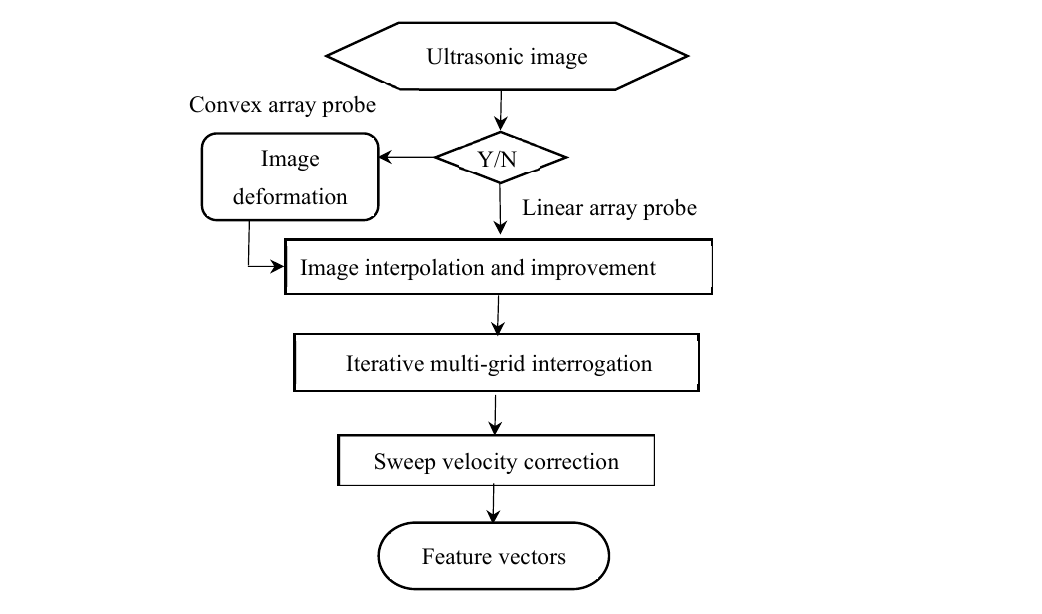
Figure 3. The main steps of the flow velocity measurement method based on the iterative multi-grid deformation technique.